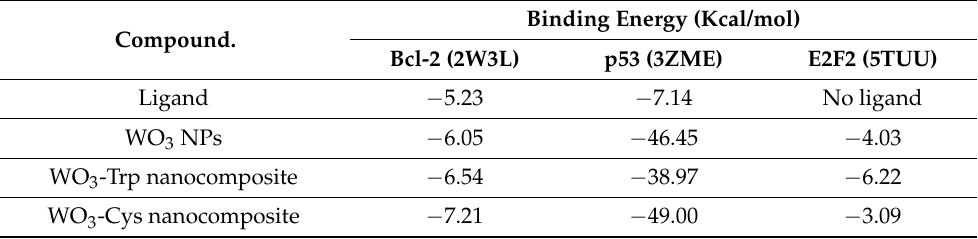
Table 3. Binding free energies of the docked